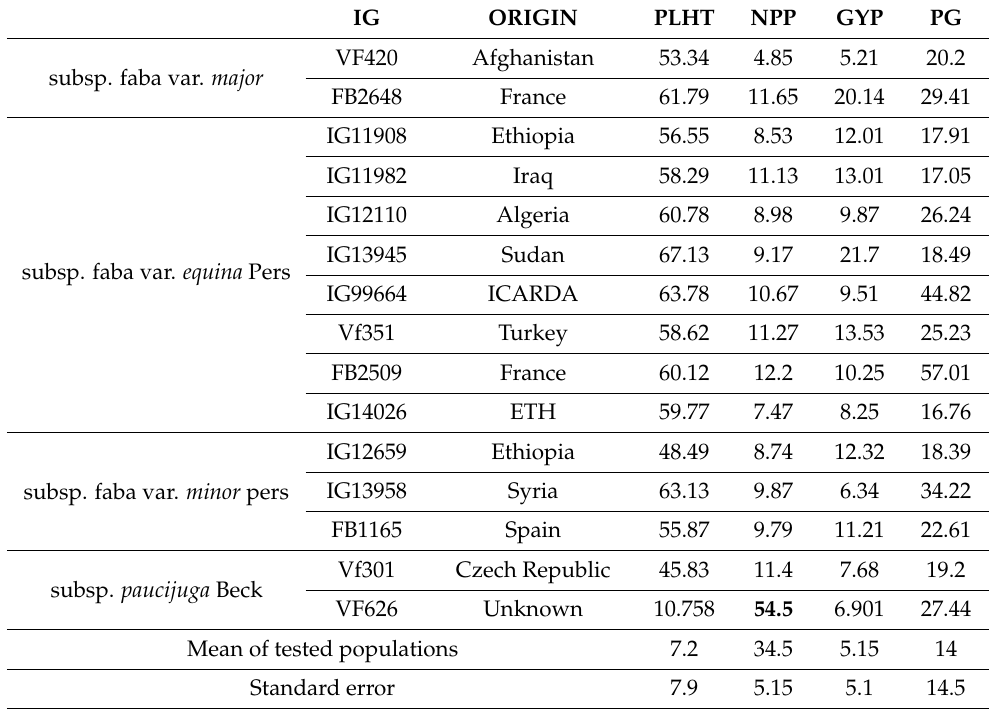
Table 5. Selected accessions tolerant to heat based on grain yield gram per plant (GYP), plant height in cm (PLHT), number of pods per plant (NPP), and pollen germination